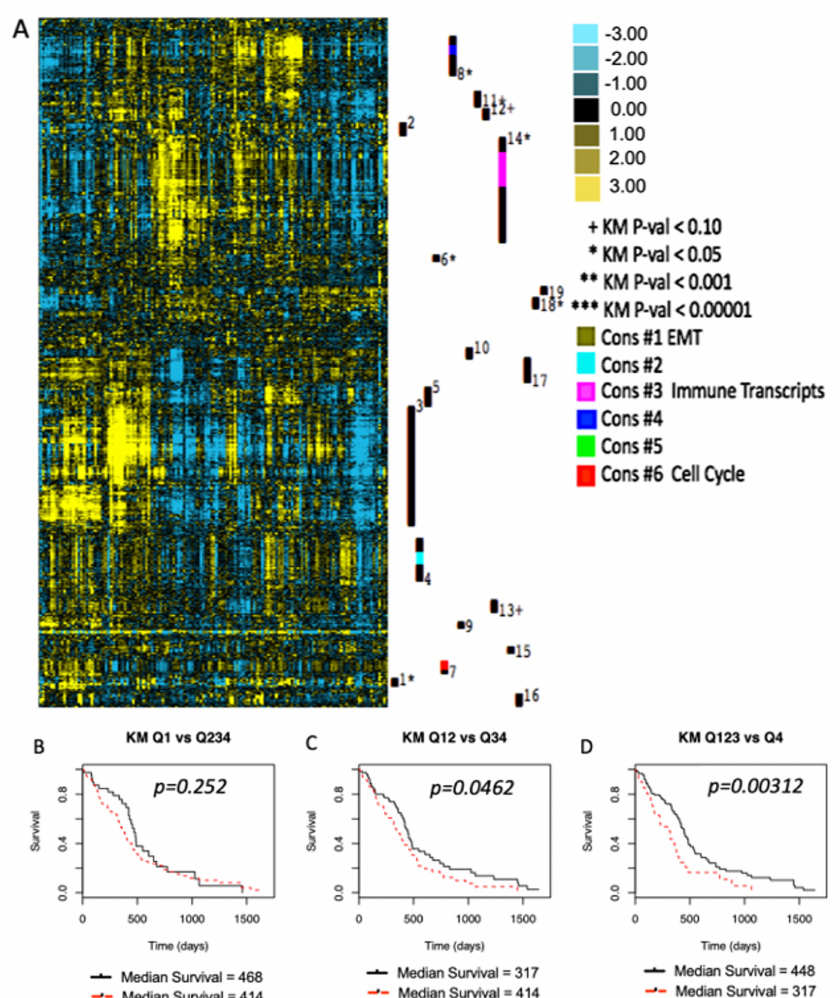
Figure 4. CD200R1-related genes are associated with shorter overall survival in humans. ( A ) Transcriptome profile for glioblastoma showing clusters of genes associated with overall survival were analyzed in patient tumor samples available in The Cancer Genome Atlas database. Transcripts with increased levels are shown in yellow, while transcripts with decreased levels are shown in blue. Transcript level clusters with correlation >0.60 and containing ≥ 60 genes were systematically identified using Gene Cluster Expression Summary Scores. These clusters are visualized with a numbered black bar to the right of each of the heatmaps. Those with significant differences in survival based on Kaplan–Meier analyses are indicated with symbols and their associated p -values are shown. ( B – D ) Kaplan–Meier plots showing that patients expressing high levels of the gene cluster containing CD200 (red lines) had shorter overall survival times than those expressing lower levels (black lines). Comparisons are top quartile (Q1) versus three lowest quartiles (Q234), top two quartiles (Q12) versus the lowest two (Q34), and top three quartiles (Q123) versus the lowest